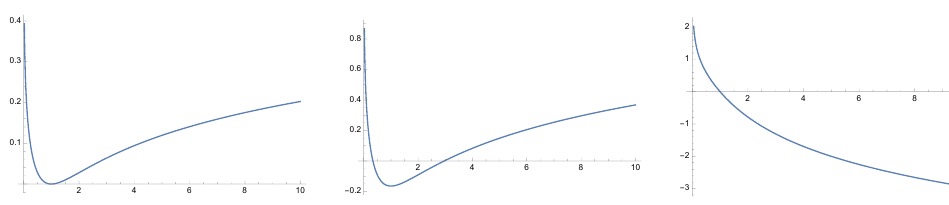
Figure 3 . The three functions ˆ A ( ρ ) , ˆ χ ( ρ ) and ˆ B ( ρ ) . Here we have chosen ρ 0 = 1 and φ 0 = − ˆ α/ 16 . but the boundary condition fixed the tension ˆ λ = 2 π and gave rise to one